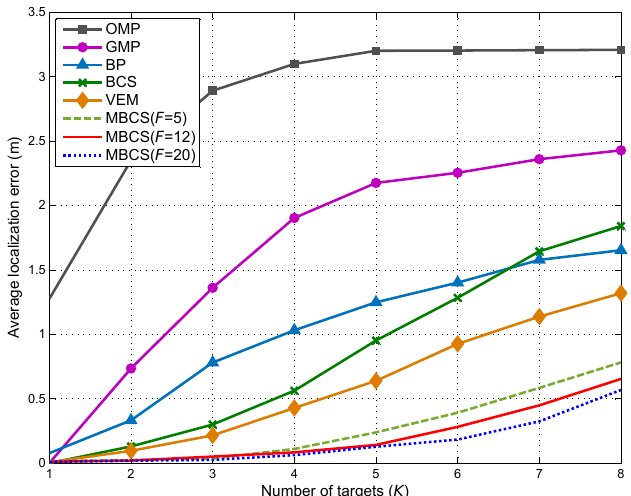
Figure 7. Impact of target number on average localization error.